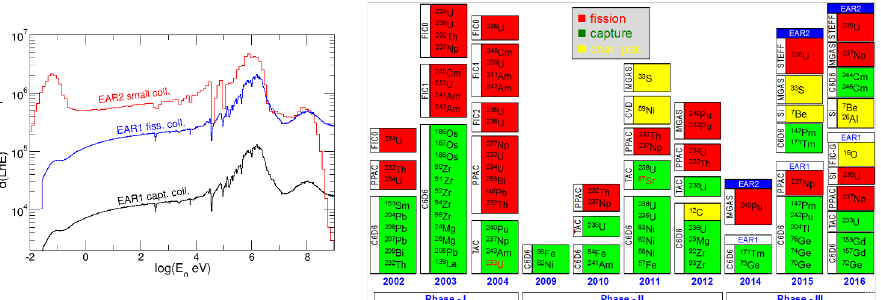
Figure 1: Flux integrated over the neutron beam spot defined by a cap- ture and a fission collimator in EAR1 and by a small collimator in EAR2.